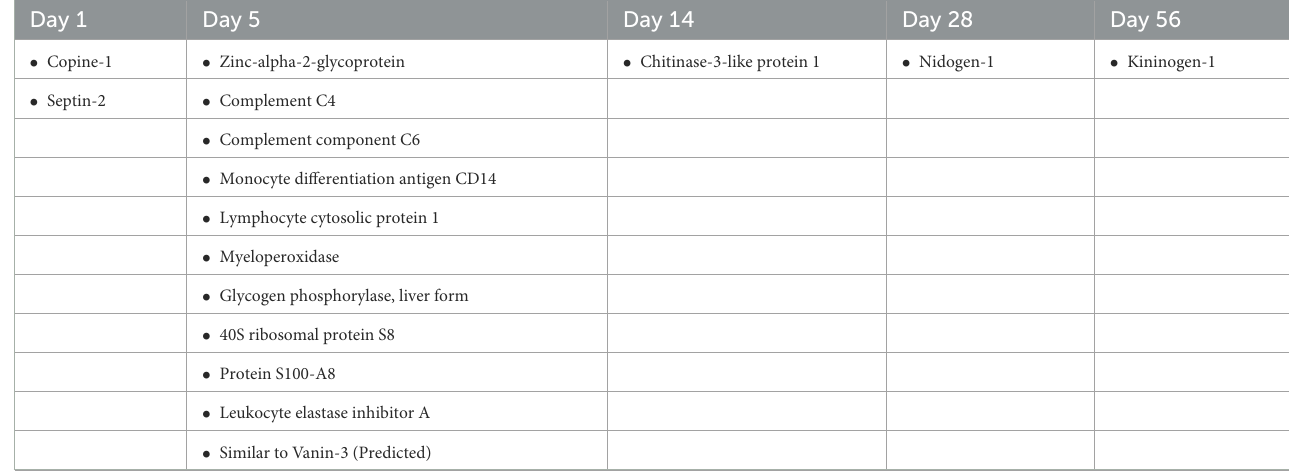
TABLE 1 Proteins that were differentially expressed in animals with P. aeruginosa, S. epidermidis, and C. acnes infection across all three species when compared to animals with sterile catheters at days 1, 5, 14, 28 and 56